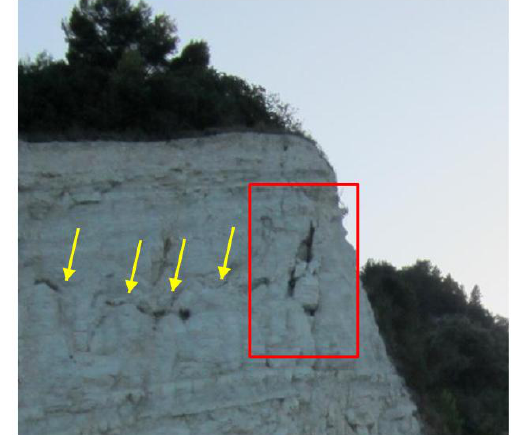
Figure 3. Likely unstable rock and scar located upslope the path usually selected by the tourist for the connection of the “spiaggia San Michele” with “spiaggia Sassi